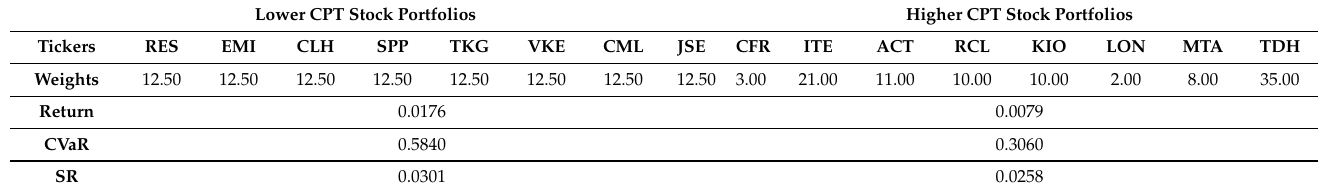
Table 5. Optimization results of JSE stock portfolios using the CBMV